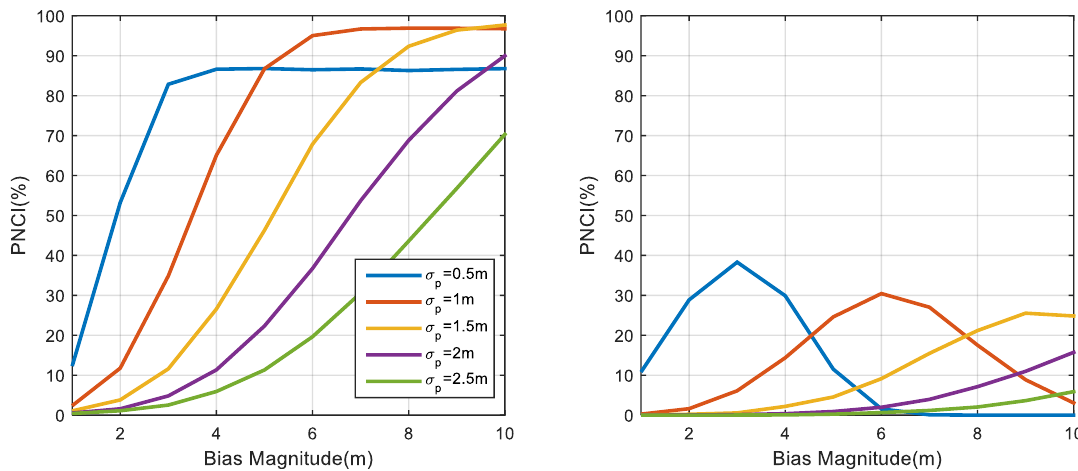
Figure 9. Compare of PNCI with different NLOS bias and measurement noise for the MC algorithm ( Left ) and the ML method ( Right ).